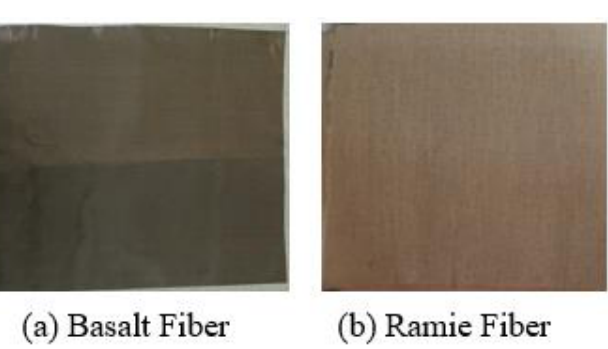
Figure 1. ( a ) Basalt ( b ) Ramie reinforcement for composite fabrication.